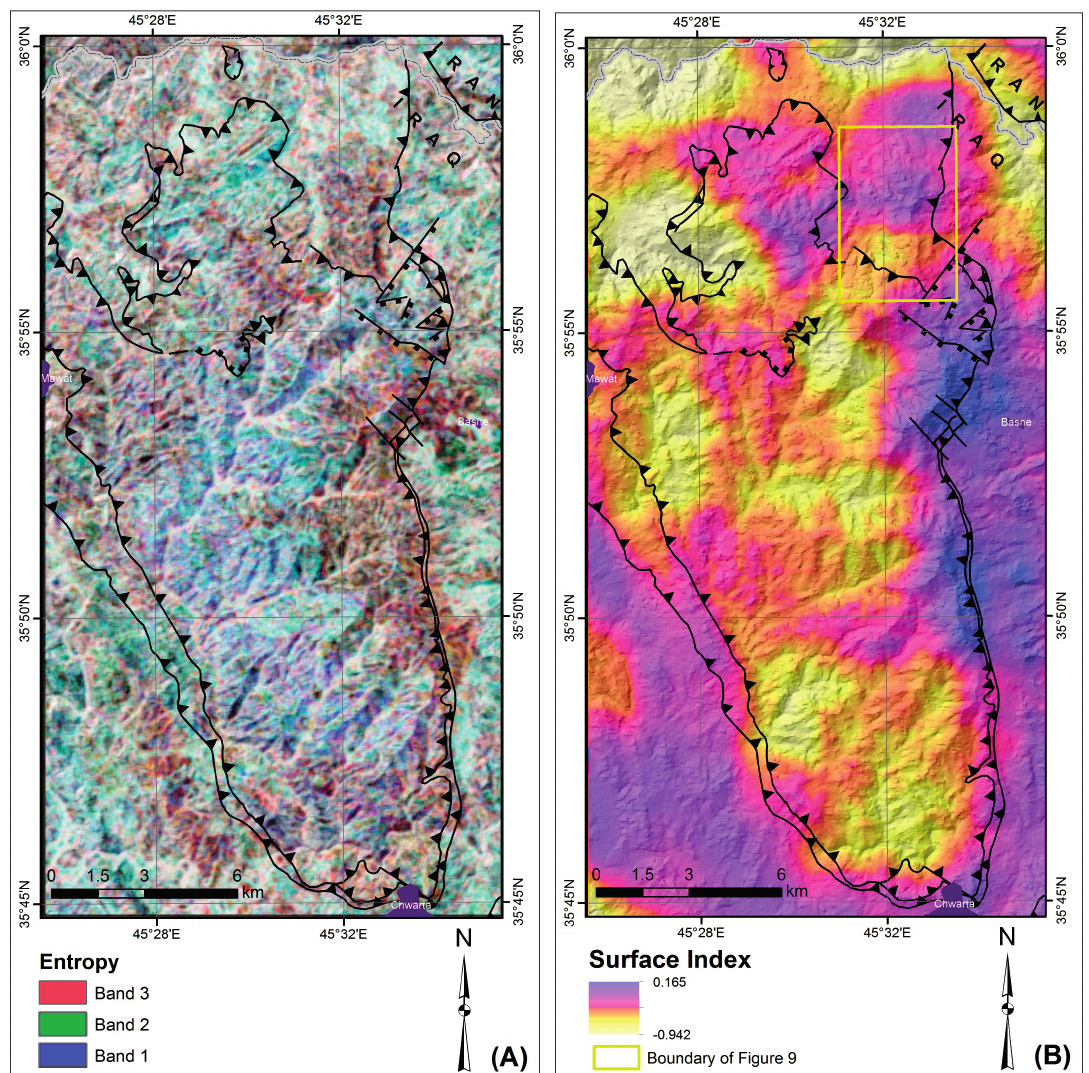
Figure 7. Thrust fault overlapping ( A ) Entropy of three texture bands for entropy measures (on bands 1, 2 and 3; R3:G2:B1); ( B ) SI map, which produced using a moving window with 100 pixels represents ~1.5 km of